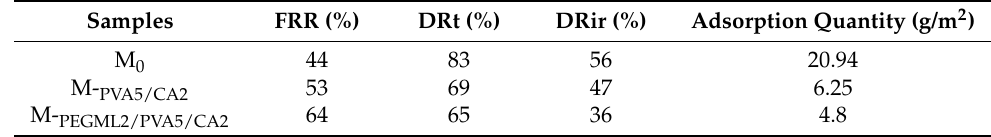
Figure 10. Testing of hydrophilic modified membranes for resistance to BSA adsorption. Table 5. Antifouling performance parameters of different PTFE microfiltration membranes. Table 5. Antifouling performance parameters of different PTFE microfiltration